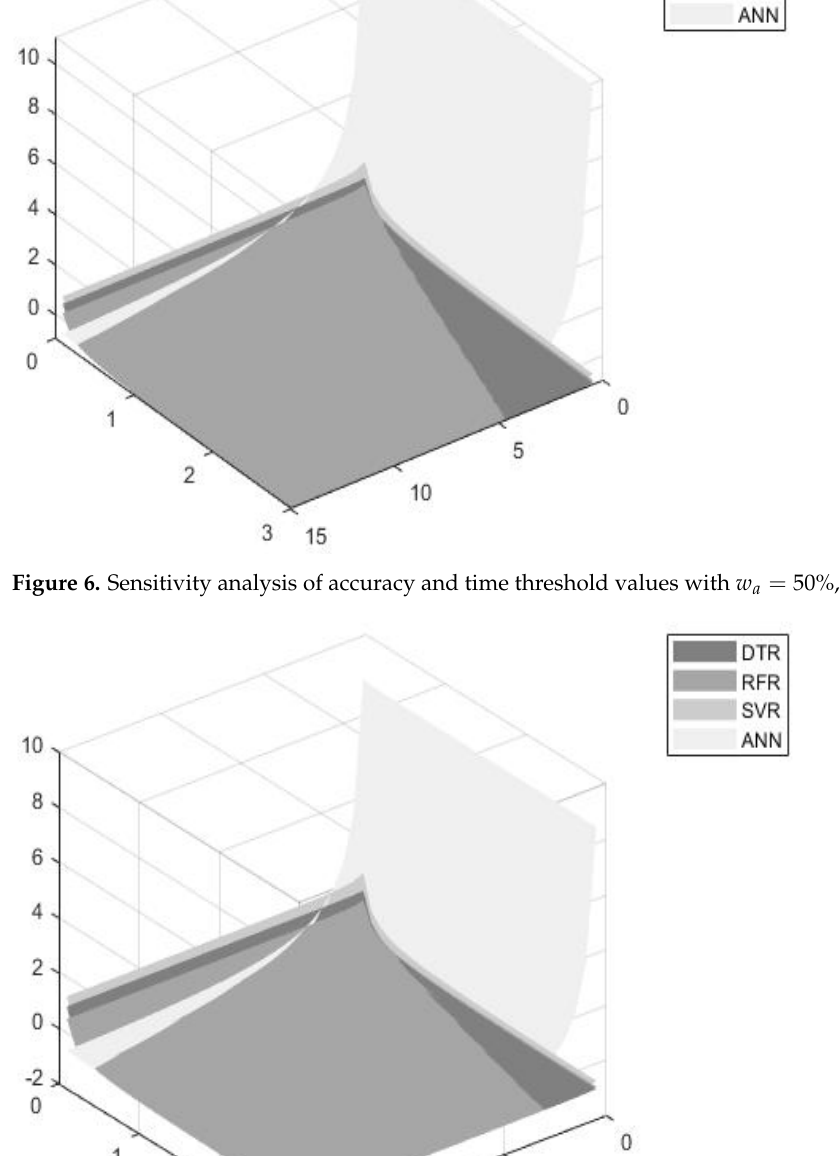
Figure 5. Sensitivity analysis of accuracy and time threshold values with 𝑤 (cid:3028) = 40% , 1- 𝑤 (cid:3028) = 60%